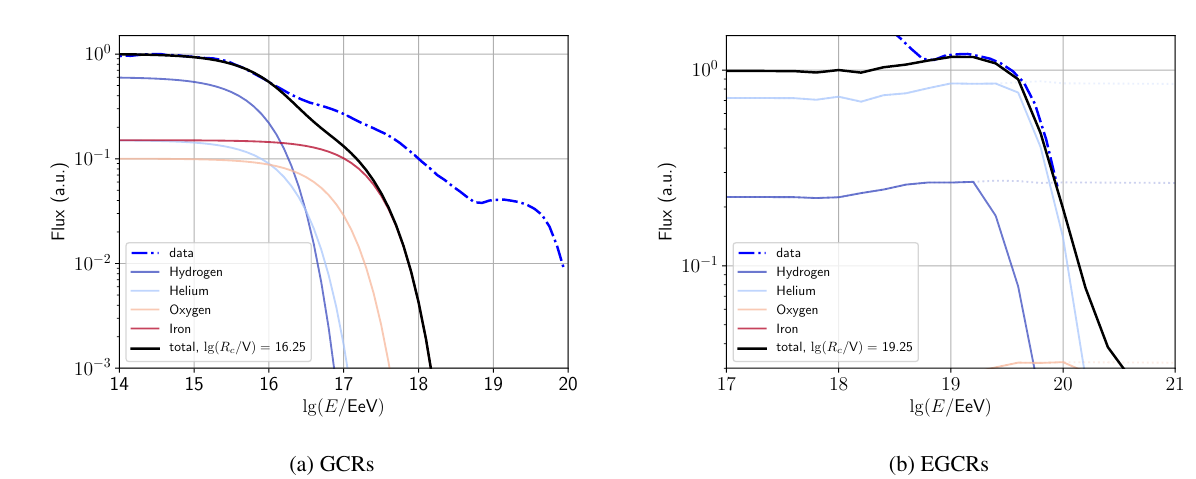
Figure 7: Predicted all-particle energy spectra for each individual class of CRs.